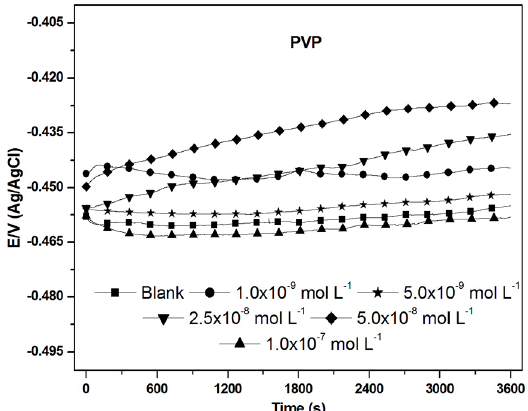
Figure 2. OCP plots of carbon steel obtained in HCl 0.5 mol L -1 in the presence and absence of PVP. Table 1. Electrochemical parameters obtained from Tafel plots for carbon steel AISI 1020, in 0.5 mol L -1 HCl in the presence and absence of different PVP concentrations. Inhibitor C (mol L -1 inh